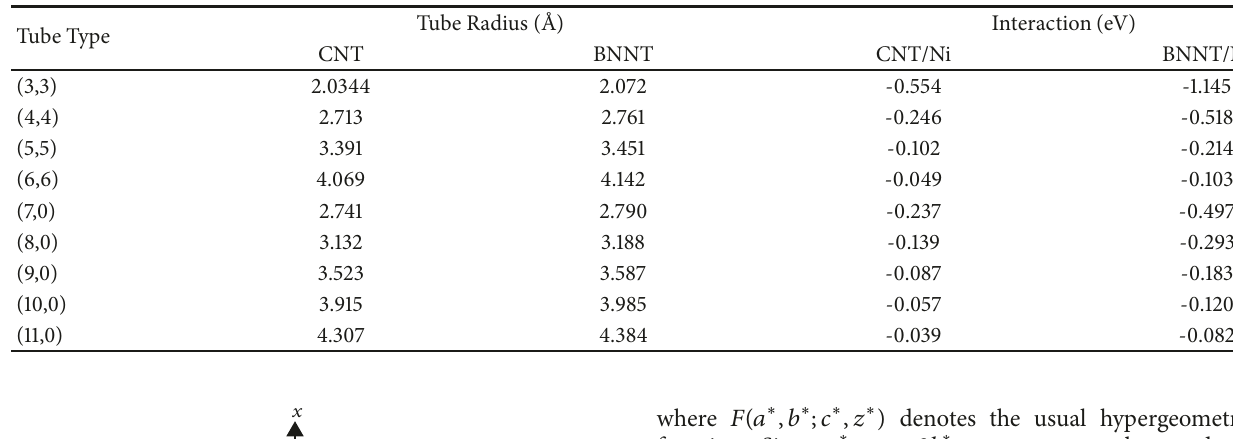
Table 2: Main results of the interaction of a Ni atom entering nanotubes.